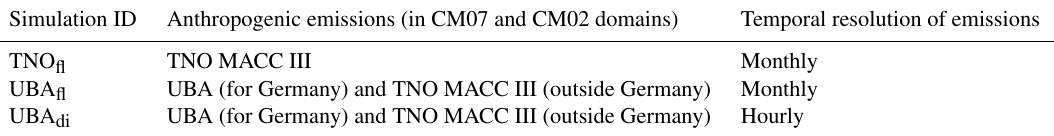
Table 1. Model set-ups. Simulation ID